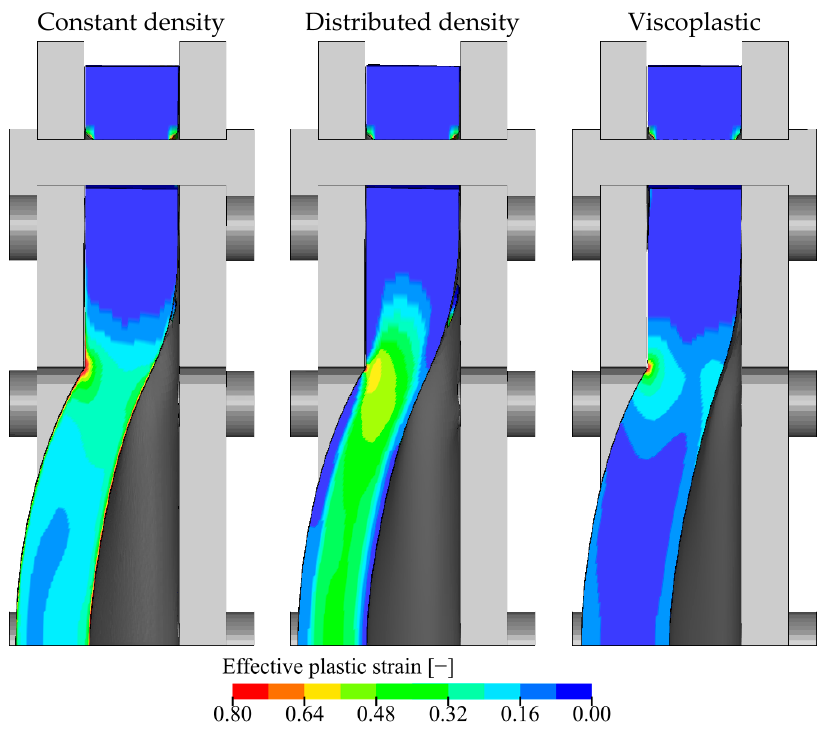
Figure A8. Deformation profiles and plastic strain from numerical simulations of test Sw_250_P12.